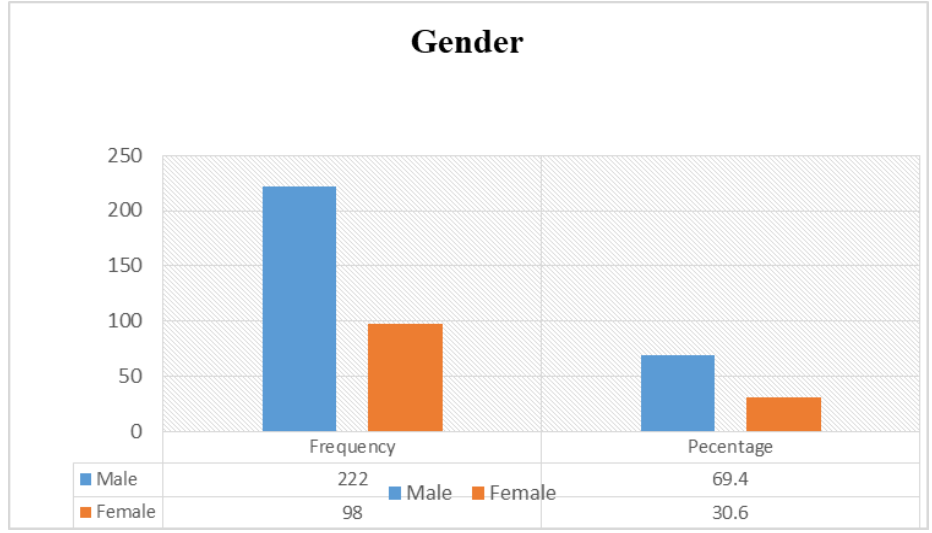
Figure 2. Gender of the Respondents; Source: Field Survey, 2017 – 2019.